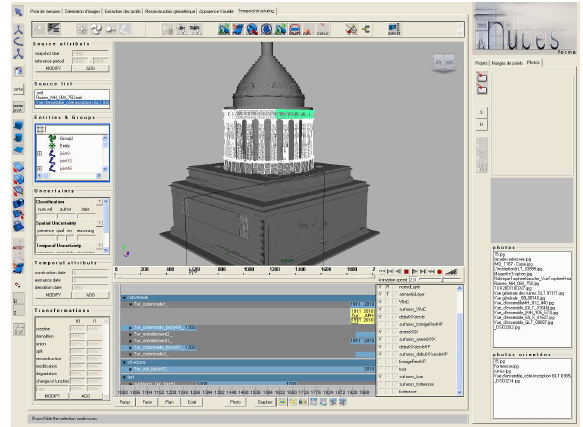
Figure 6. User interface displaying state diagrams, timeline and window